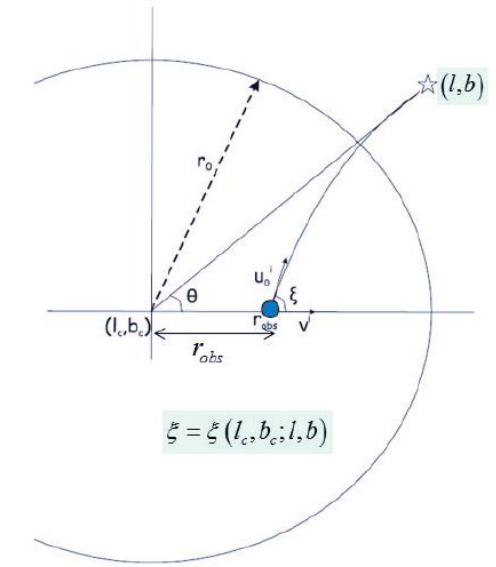
Figure 11. The lightlike geodesics for an off-center depend on two additional parameters r and ξ obs